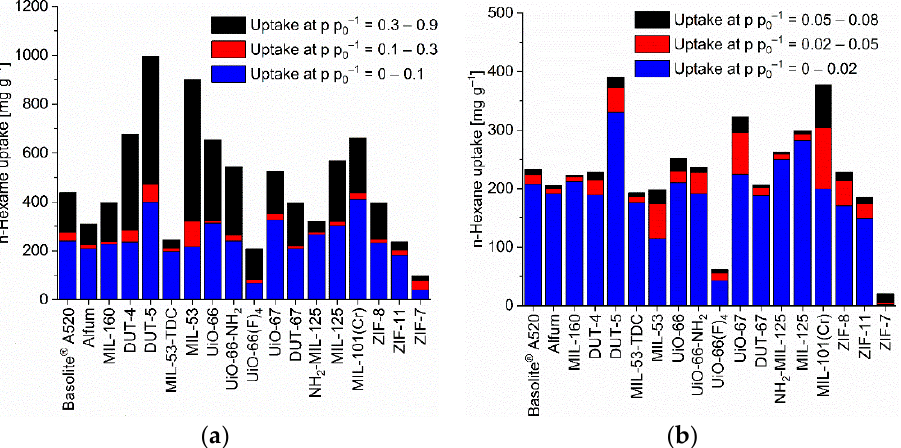
Figure 4. n -Hexane uptake capacity (at 293 K) of the different MOFs at different relative pressures. ( a ) At relative pressures of 0.1, 0.3 and 0.9; ( b ) at relative pressures of 0.02, 0.05 and 0.08 (specific values in Table S7). For the surface-specific uptake at p p 0 − 1 = 0.1 see Figure S88c.